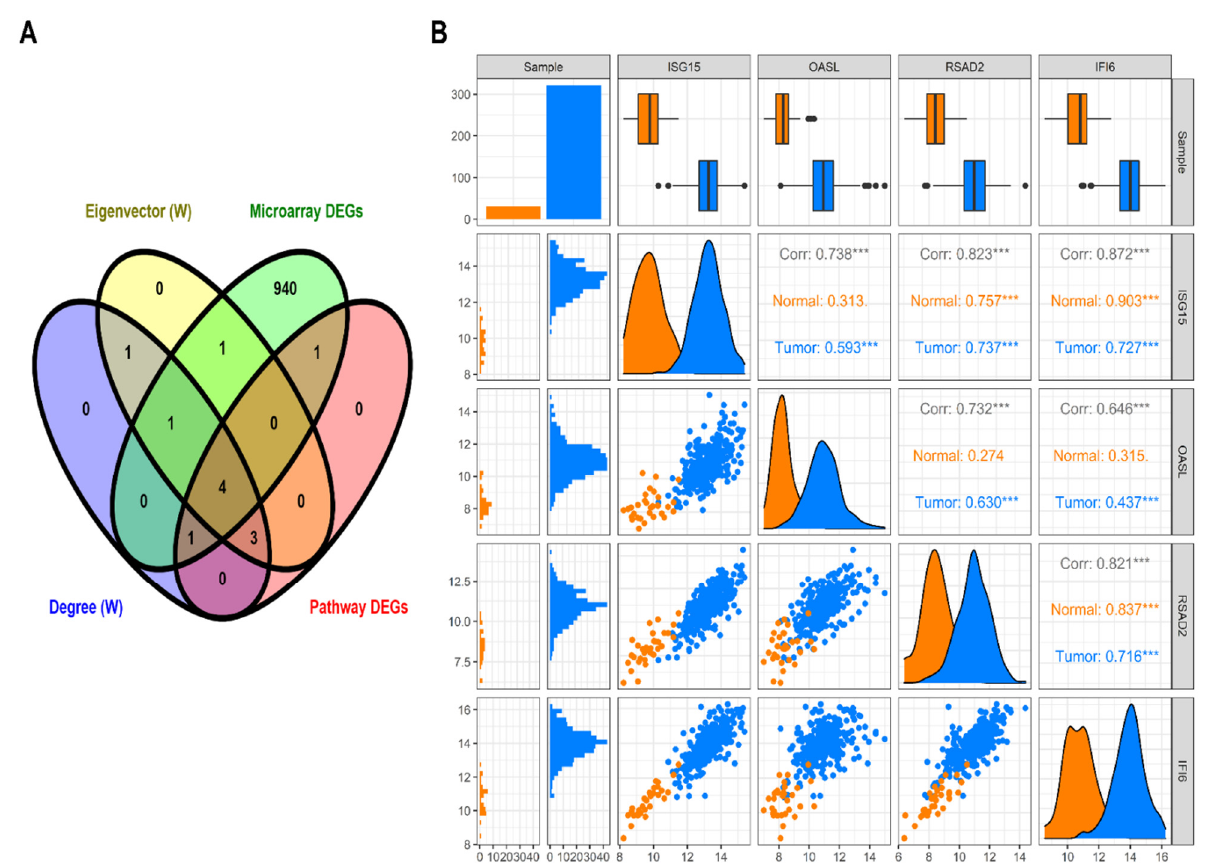
Figure 7. OSCC-specific hub genes and association between them. ( A ) Venn plot showing four overlapping OSCC-specific hub genes between the top 10 ranked genes (based on weighted degree and weighted eigenvector), top 10 significant pathway genes (nine), and OSCC microarray DEGs (948). Yellow, violet, red, and green colored areas in the Venn plot represent gene sets corresponding to weighted eigenvector, weighted degree, pathway DEGs, and OSCC microarray DEGs. ( B ) Pairwise scatter plot showing the associations amongst these four upregulated OSCC-specific hub genes. The upper triangular section represents the Spearman correlation coefficients between these hub genes along with expression boxplots for each gene. The lower triangular section represents the scatterplot and histogram distribution between these genes. The diagonal consists of kernel densities for each gene. The asterisk (***) sign indicates the moderate and higher correlation values.